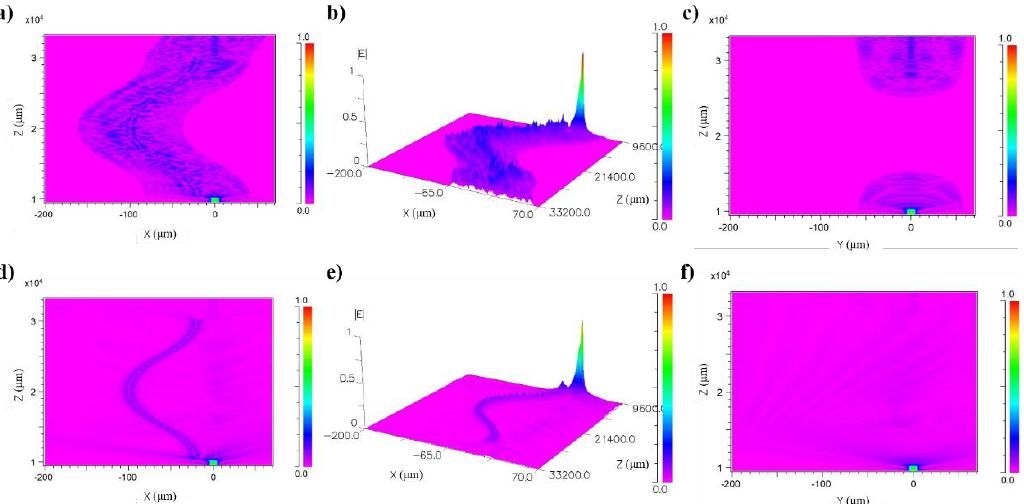
Figure 2. The simulation results of the mismatched fiber structure with normal cladding ( a – c ) and very thick cladding ( d – f ).